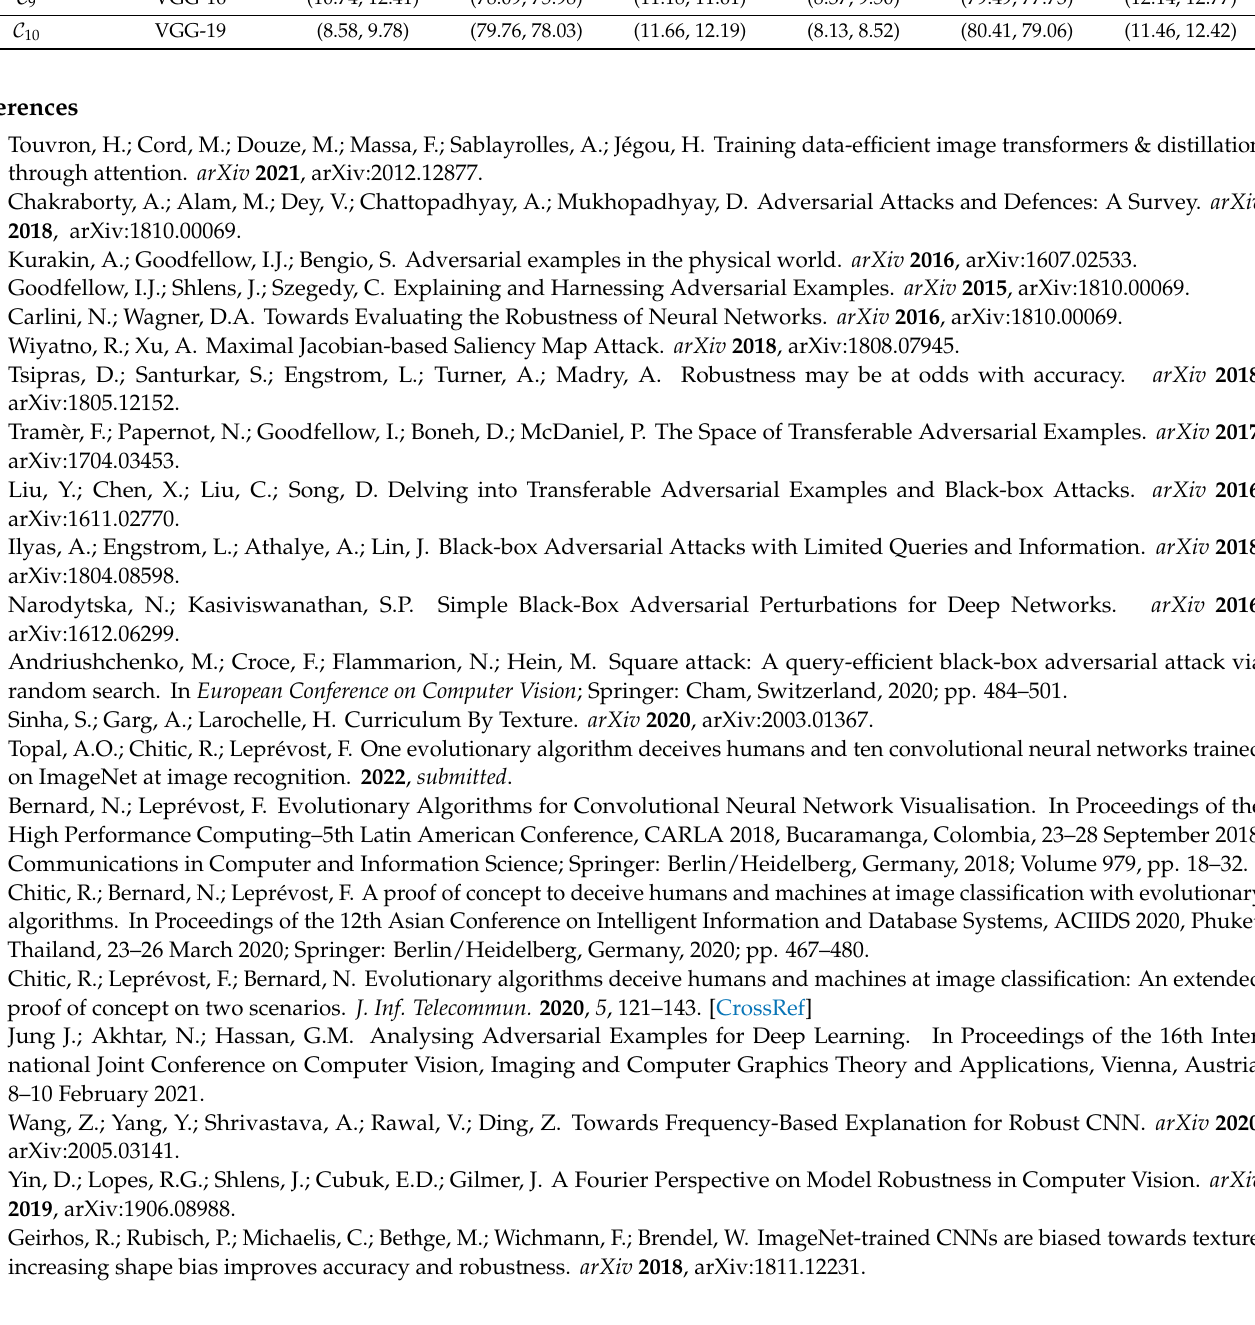
( A p ) . Each cell q 1